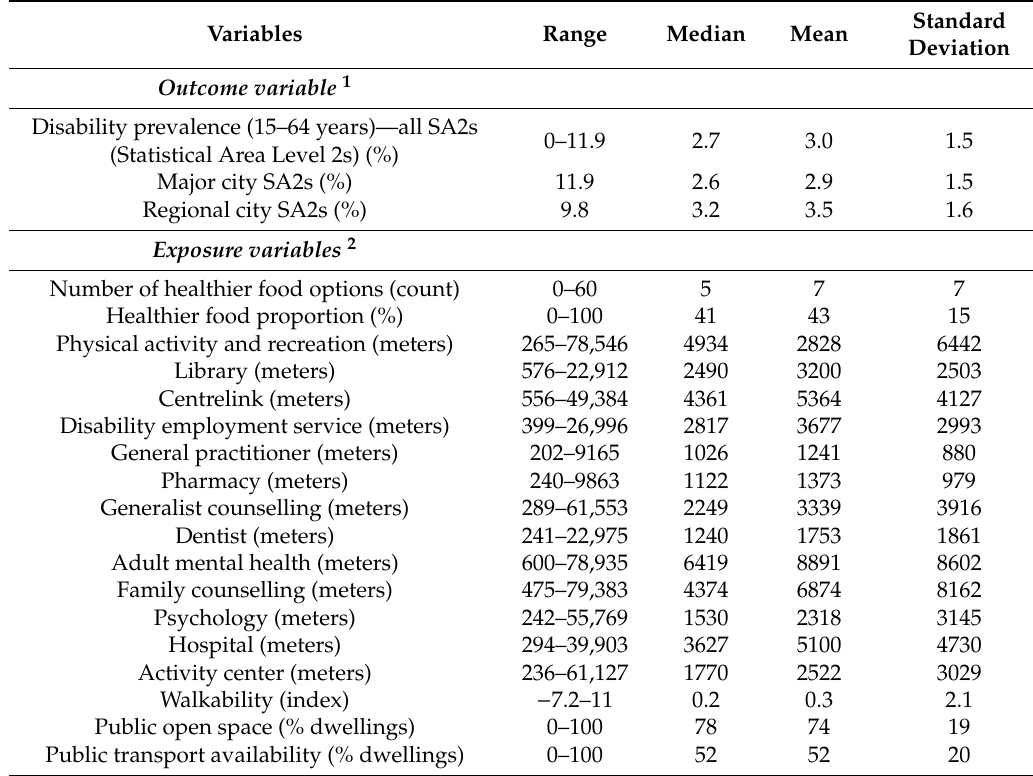
Descriptive statistics for exposure (built environment) and outcome (disability prevalence)